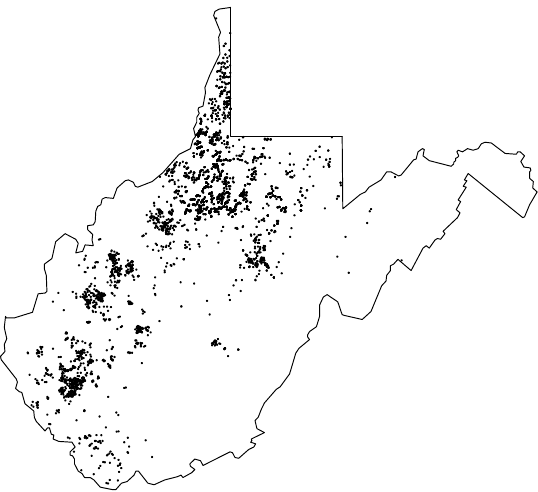
Figure 2. Locations of Oil and Gas Wells in West Virginia.